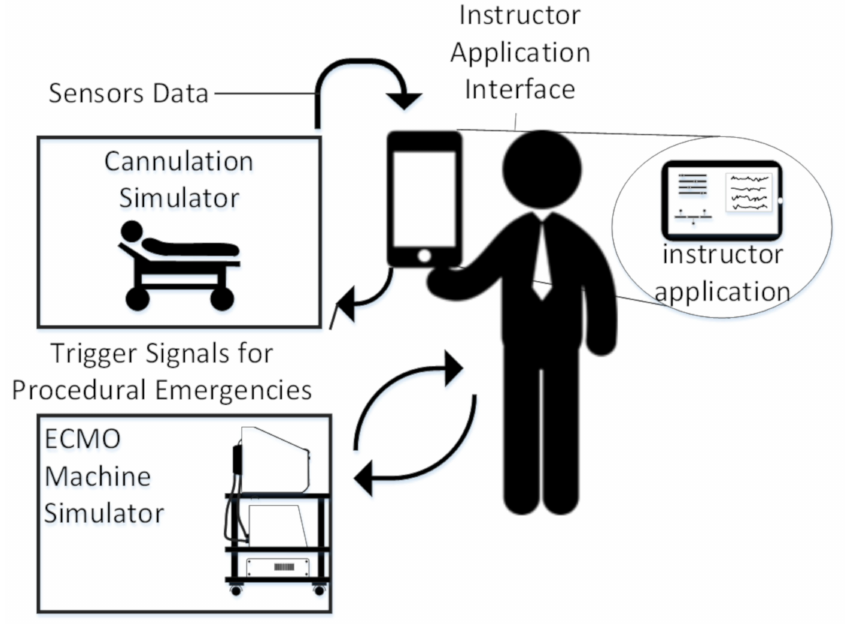
Figure 20. Block diagram of the overall case